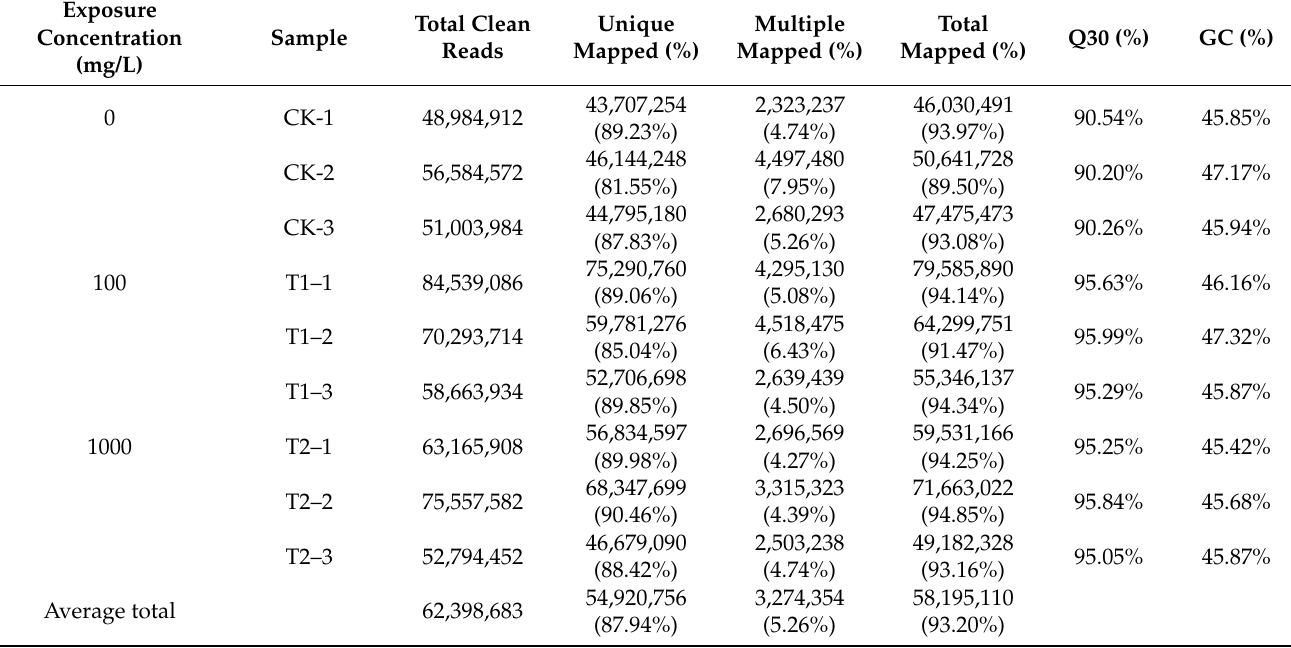
Table 1. Summary of the sequencing reads and read